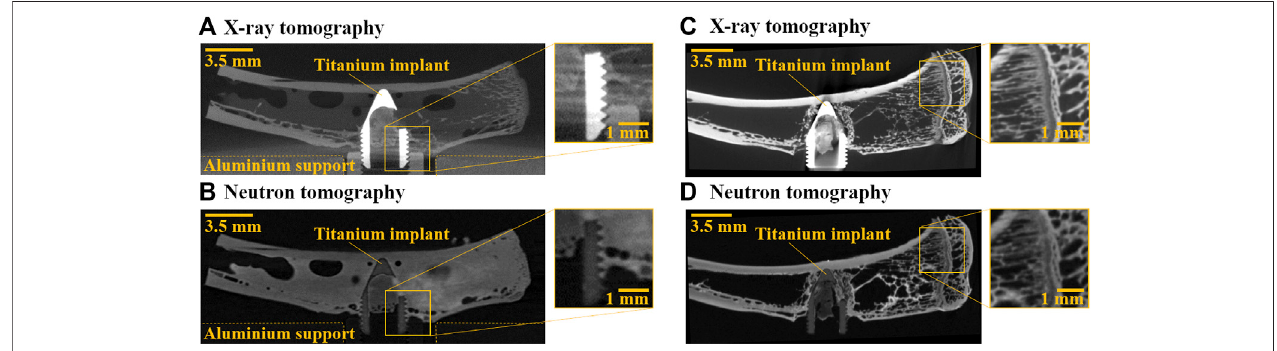
FIGURE1| Studymotivation. (A) X-rayand (B) neutrontomographyimages ofahydrated distalrattibiaewithatitaniumimplant. In theX-rayimage, artifactsclose to the metal obscure the bone-implant interface. In the neutron image, no image artifacts occur around the implant, but the free water inside the specimen